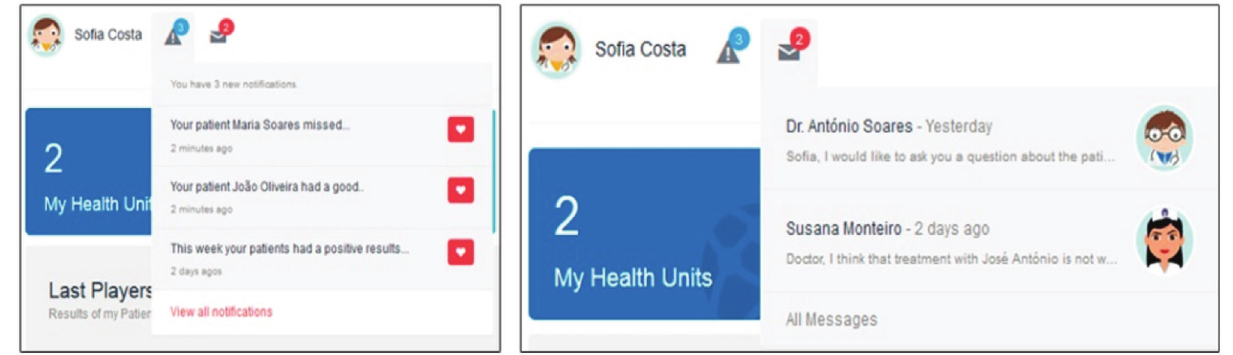
Figure 13: Boxes of alert notifications and